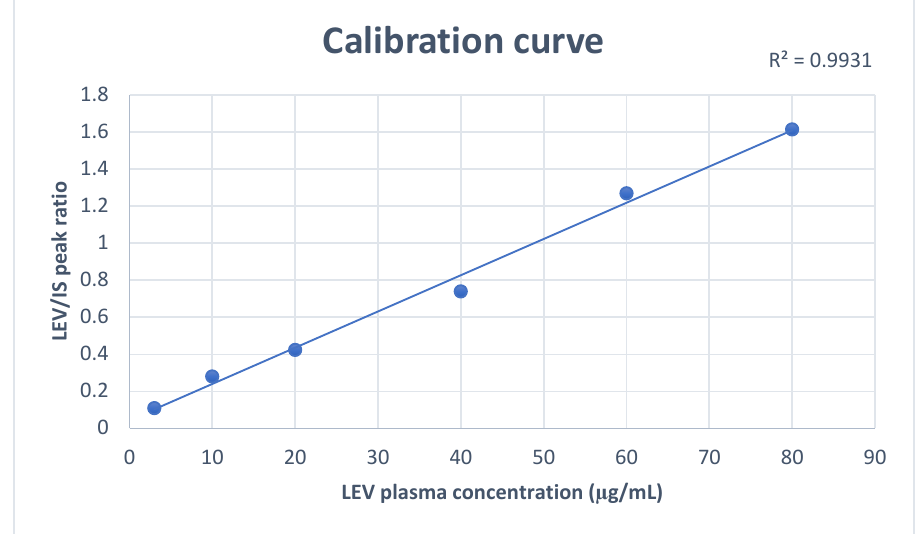
Figure 3. A representative calibration curve of Levetiracetam throughout the range 3–80 μg/mL. Table 1. Method inter- and intra-day precision (%CV) and accuracy (% error) for Levetiracetam. QC